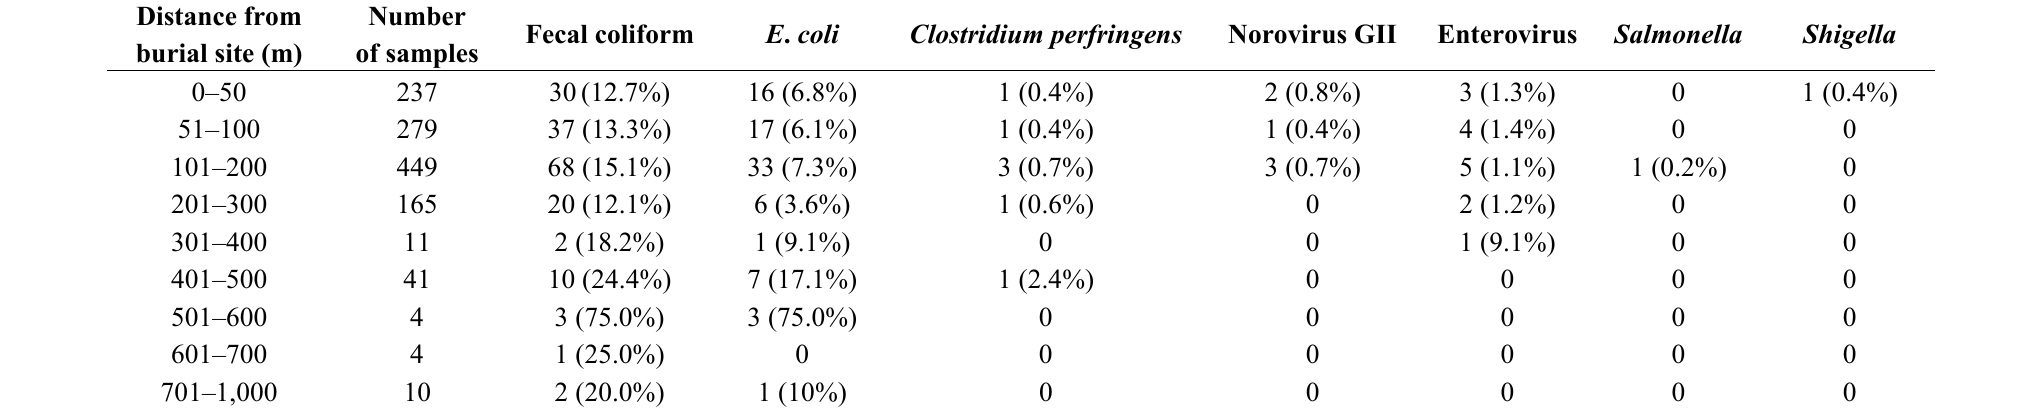
Table 3. Distance from burial and detection of microorganisms.